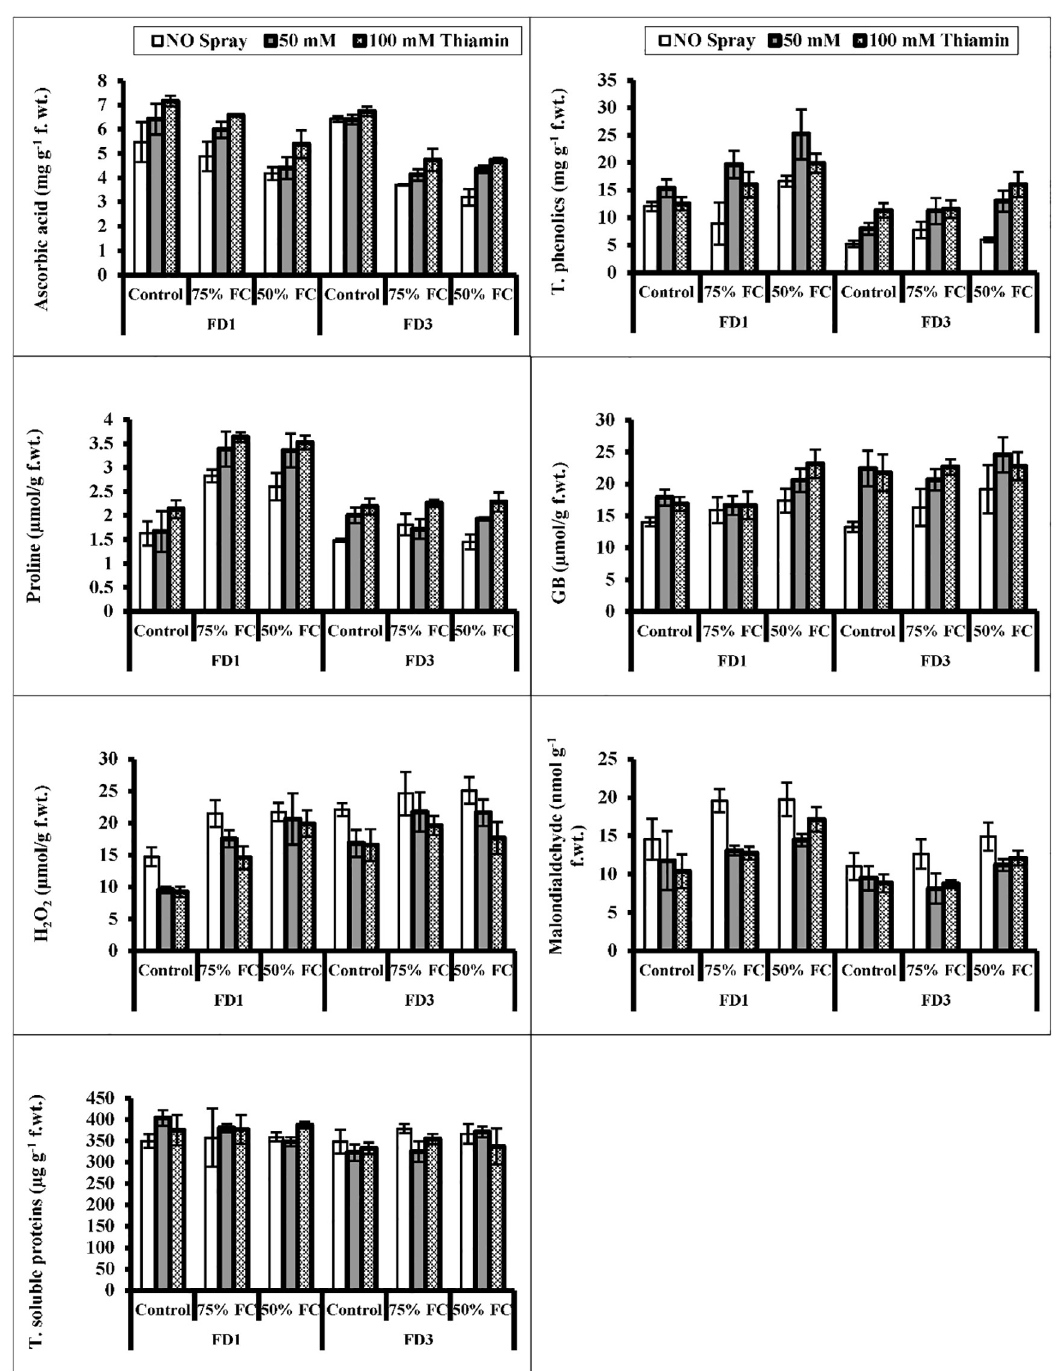
Fig 4. Ascorbic acid, total phenolics, proline, GB, hydrogen peroxide, MDA and total soluble proteins in the inflorescence of two cultivars of cauliflower ( Brassica oleracea L.) plants foliarly treated with thiamin (50 and 100 mM) subjected to control (100% field capacity) and drought stress (75% and 50% field capacities). A significant increase in inflorescence proline and GB contents was observed under water-deficit conditions (Fig 4). Exogenous application of thiamin increased ( P � 0.001) the contents of GB and proline in both cauliflower cultivars under varying water regimes. A maximum increase in GB and proline contents was recorded in cauliflower plants at 50% F.C.